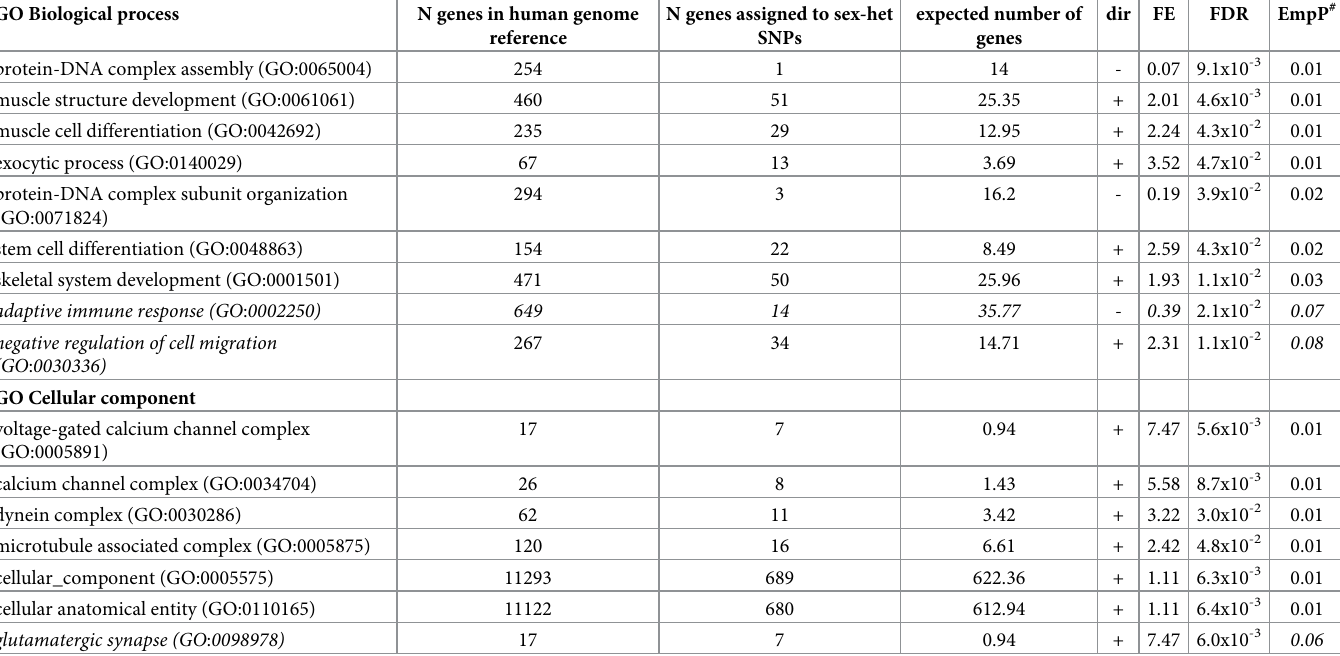
Table 3. Enriched GO biological processes and cellular components in biometric trait sex-heterogeneous mapping genes (in/within 25kb distance) using ORA. GO Biological process